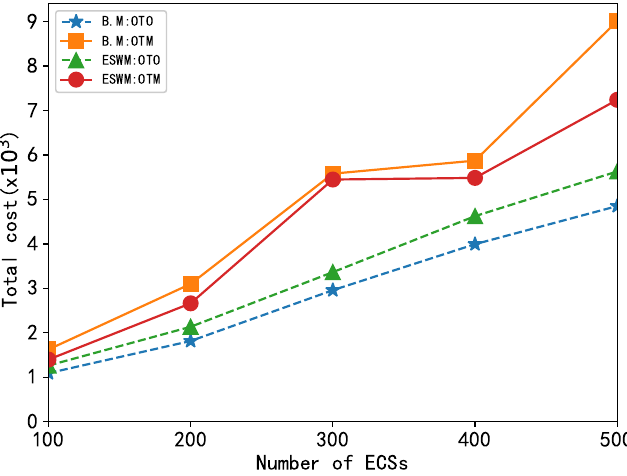
Figure 3. Comparison of total costs under different incentive mechanisms.